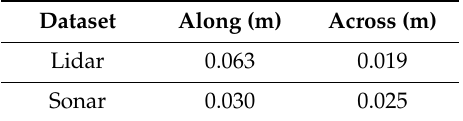
Table 1. Mean spacing to 8 nearest neighbours for each